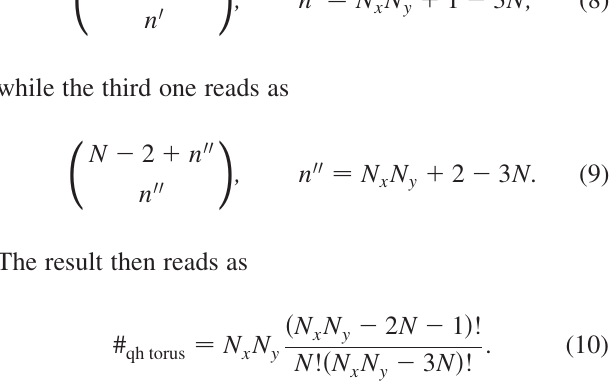
FIG. 16. Entanglement spectrum gap (cid:2) PES as a function of M at filling (cid:1) ¼ 1 = 3 for N ¼ 8 and N ¼ 10 with N x ¼ 6 . N= 2 , N y ¼